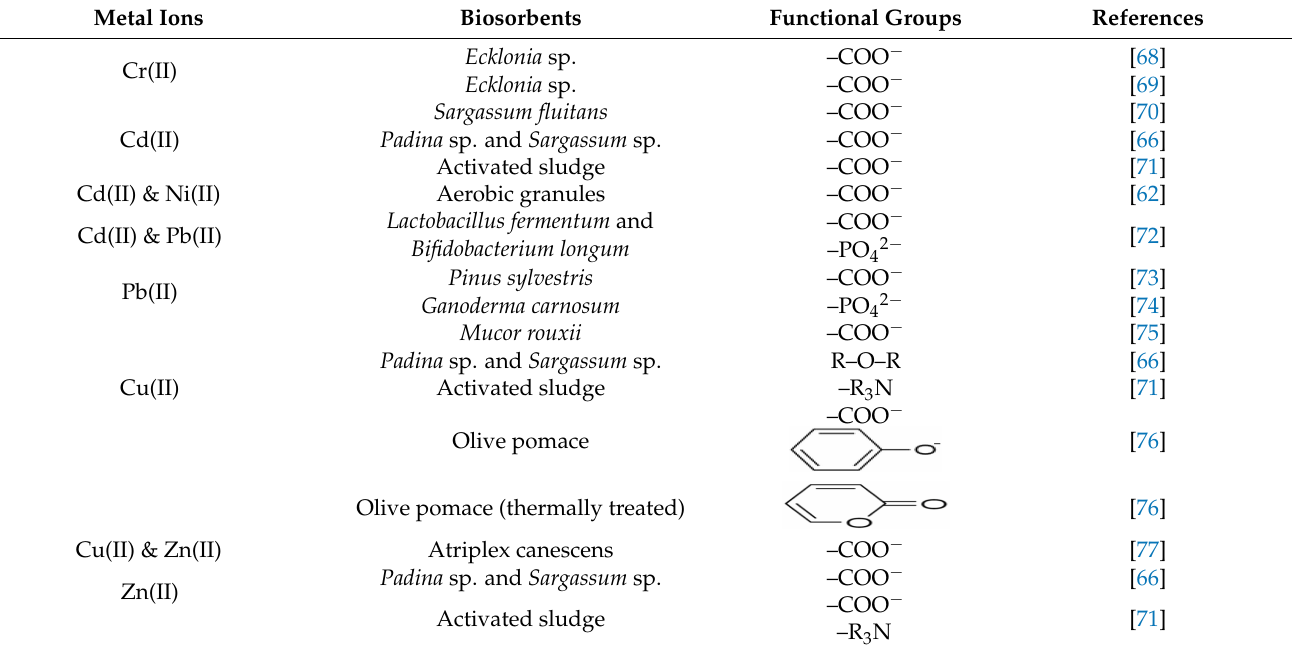
Table 2. Surface complexation between metal cations and functional